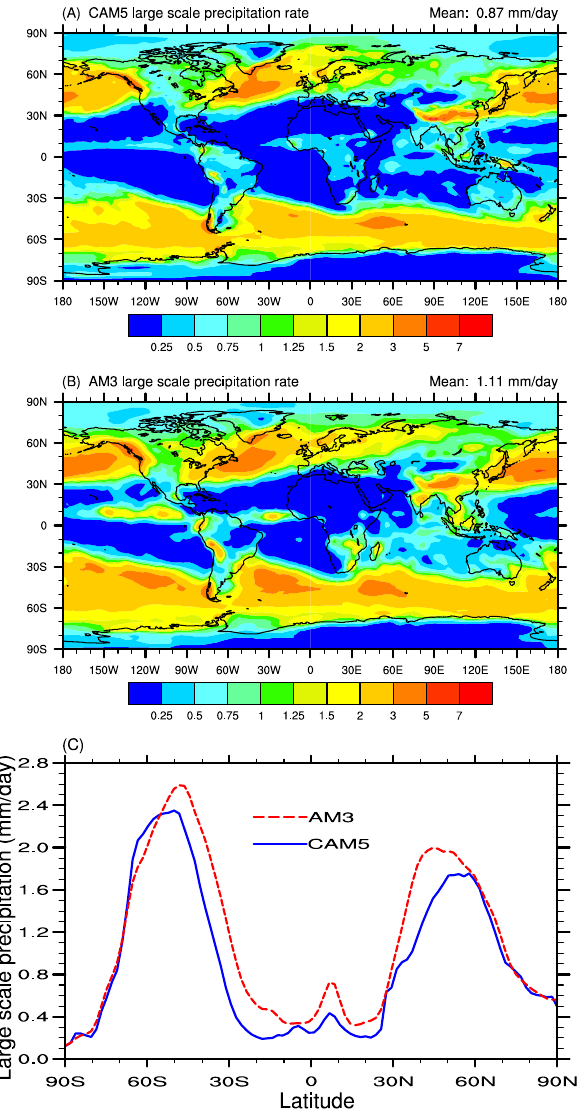
Fig. 3. Annual average surface total large-scale precipitation (mmday − 1 ) from CAM5 and AM3. (A) CAM5, (B) AM3, and (C) the annual zonal average surface large-scale precipitation (mmday − 1